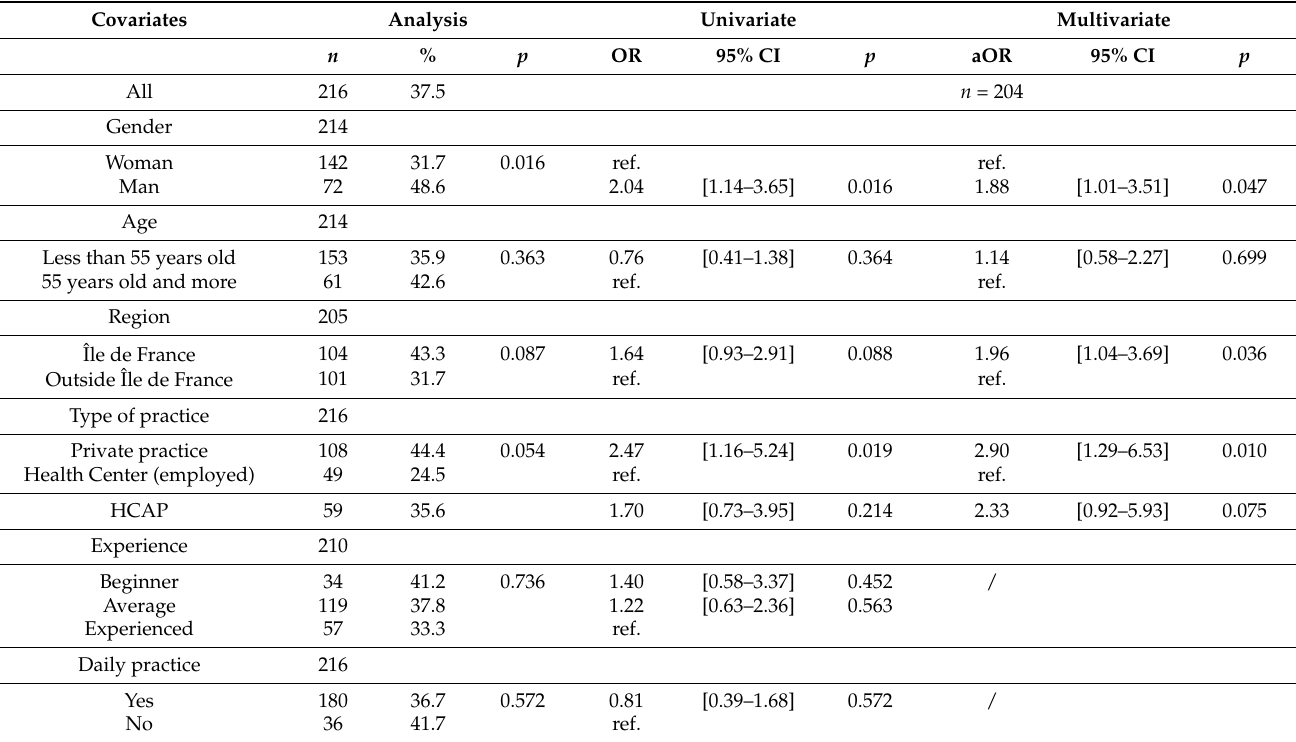
Table 1. Results of logistic regression models estimating the association between carrying out a systematic full primary series of vaccines and general practitioner’s profile, among 219 general practitioners interviewed in France (2017–2018).